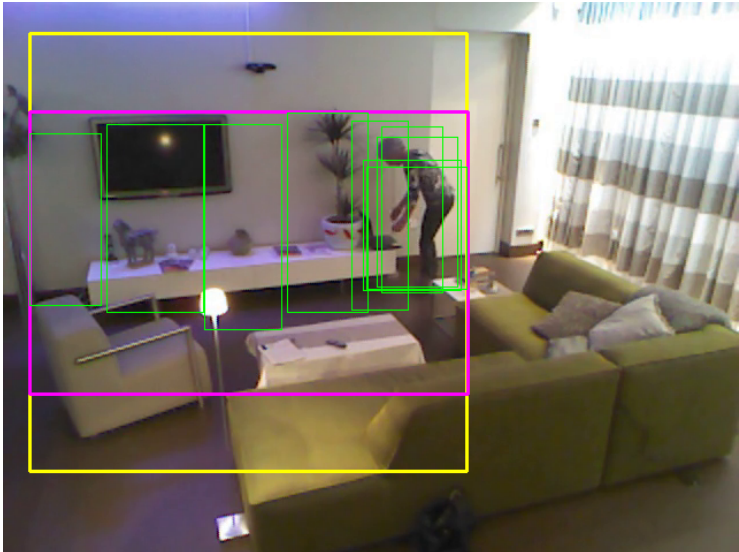
Figure 3. Frame from a ‘Walk’ sequence showing the full crop concept: a crop involving the full area where the activity takes place (bounding box in purple). The yellow bounding box shows the square area of the final image crop. Bounding boxes of each separate detection shown in green. For visibility, only one in every 10 detections (green bounding boxes) is